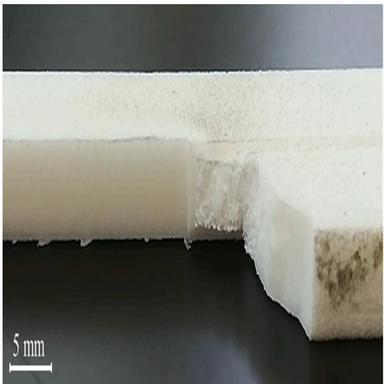
Representative surface of crack propagation at the end of the DCB test.